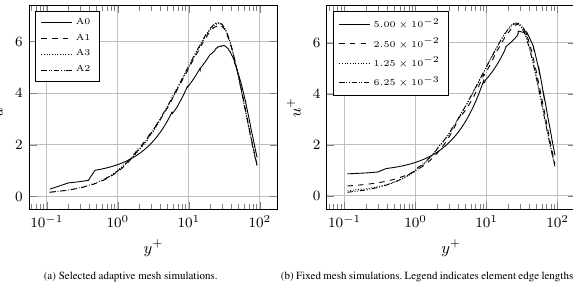
Fig.5:Wallnormalvelocityprofileatthelocationofthenoseofthegravitycurrentat t =7 . 5 forthefixedmeshsimulations andselectedadaptivesimulations.Notethat A 2 isahigherresolutionsimulationthan A 3 . Figure 5. Wall normal velocity profile at the location of the nose of the gravity current at t = 7 . 5 for the fixed mesh simulations and selected adaptive simulations. Note that A2 is a higher-resolution simulation than A3.